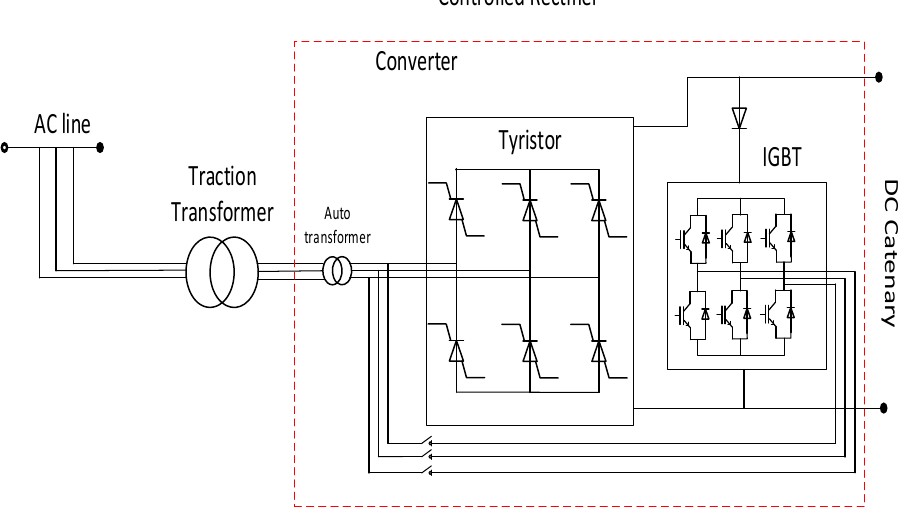
Figure 18. Improved HESOP converter by SNCF [126].